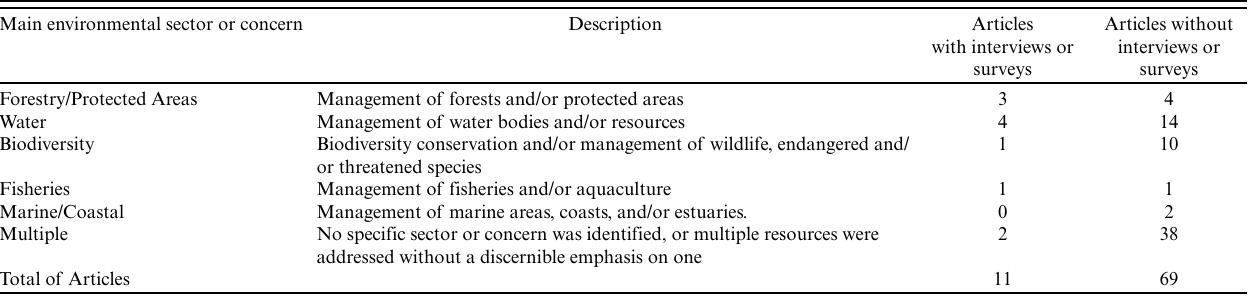
Table 1 . Categorization of publications by environmental sector or concern, and use of interviews or surveys as a research method. Main environmental sector or concern